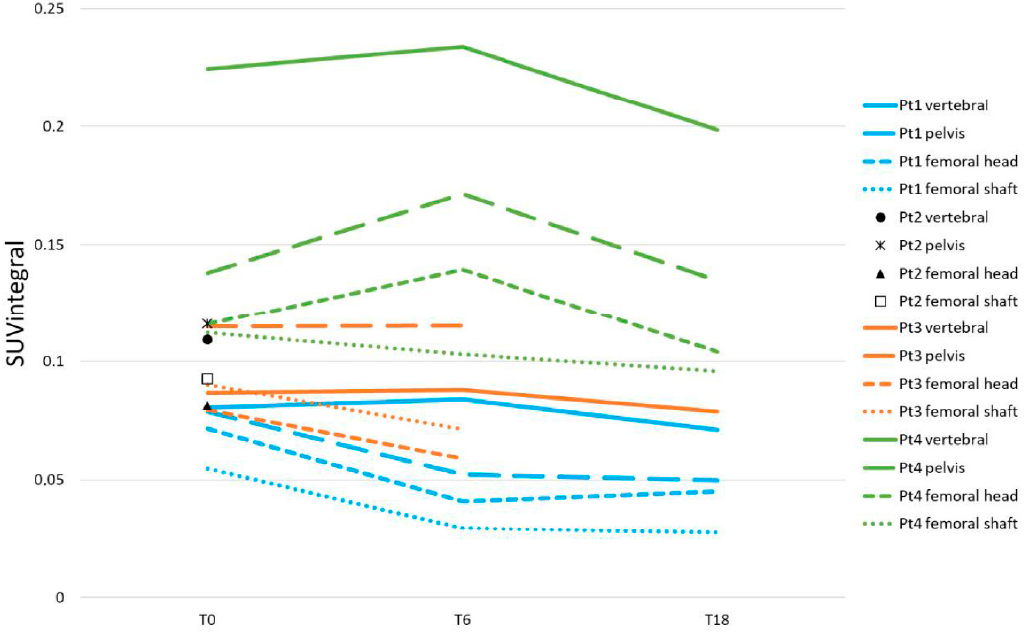
Figure 6. SUVintegral as measured by [ 18 F]NaF PET. Table 4. Imaging results.